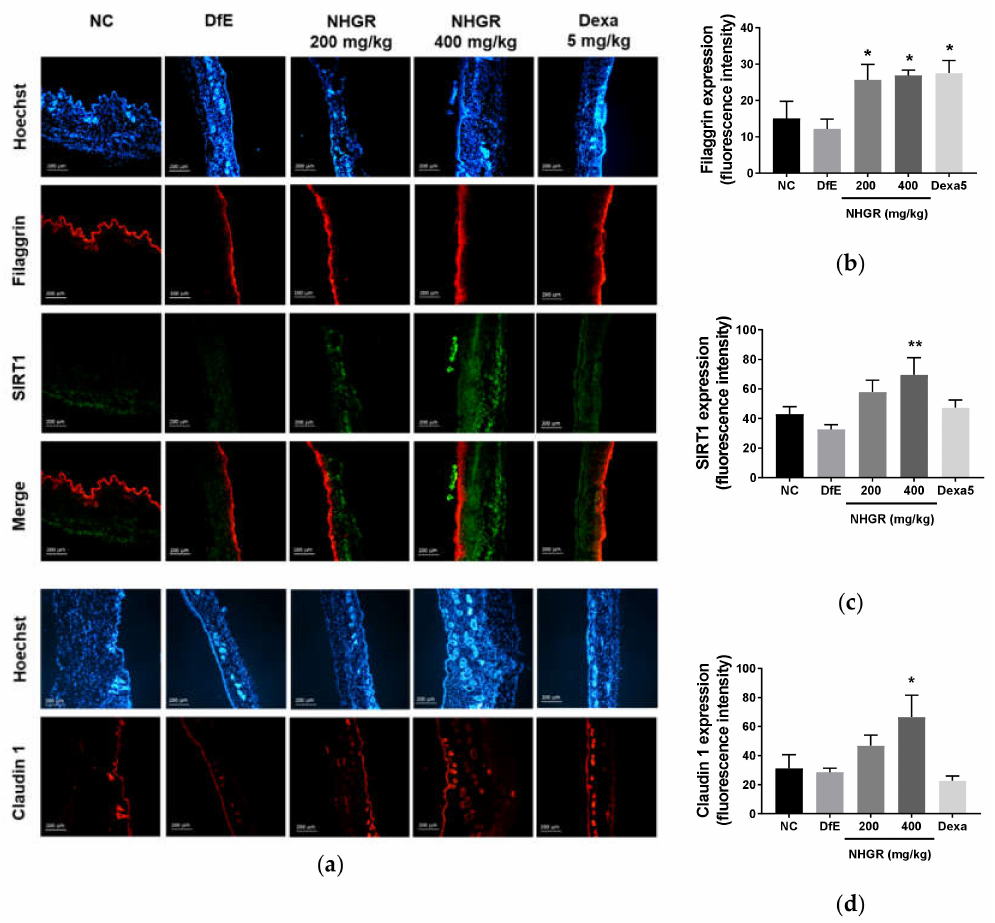
Figure 5. Immunohistofluorescence staining of SIRT1, claudin 1, and filaggrin in the dorsal skin tissue of NC / Nga mice. ( a ) SIRT1 (green), filaggrin (red), merge of filaggrin and SIRT1 (red), claudin1 (red), and Hoechst (blue). Densitometric quantification of filaggrin ( b ), SIRT1 ( c ), and Claudin1 ( d ). Fluorescence values quantified by the Image J program are represented as bars. Values are expressed as means ± SEM ( n = 7). * p < 0.05 and ** p < 0.01 compared with Dermatophagoides farinae extract (DfE)-treated atopic dermatitis